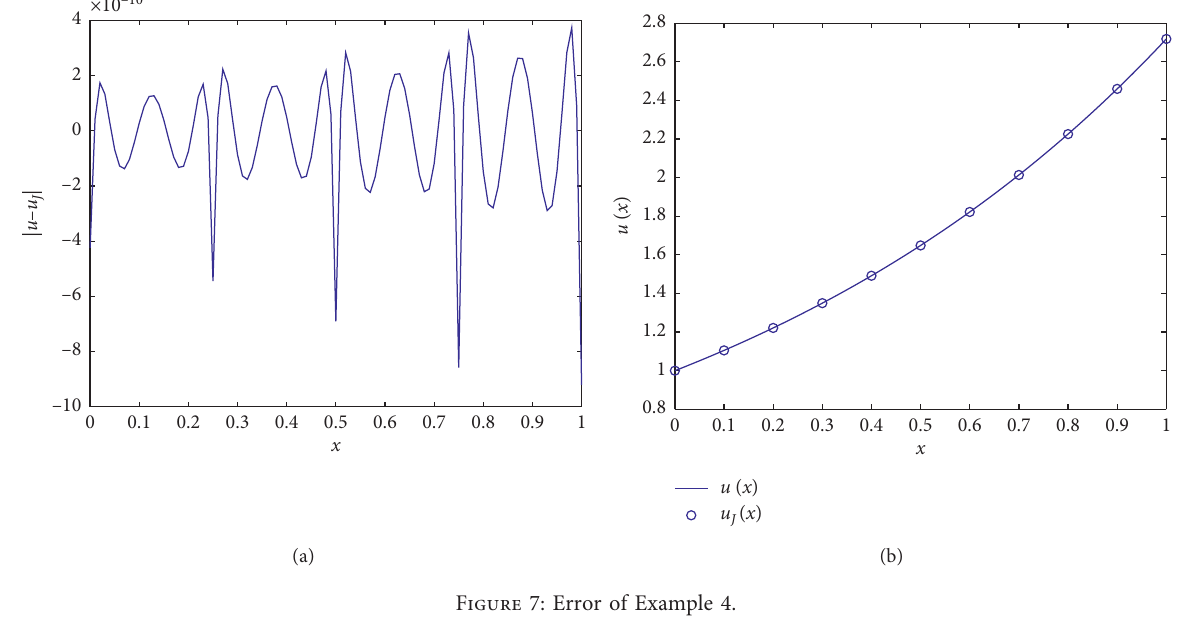
Figure 7: Error of Example 4. Table 4: Comparison of the error for Example